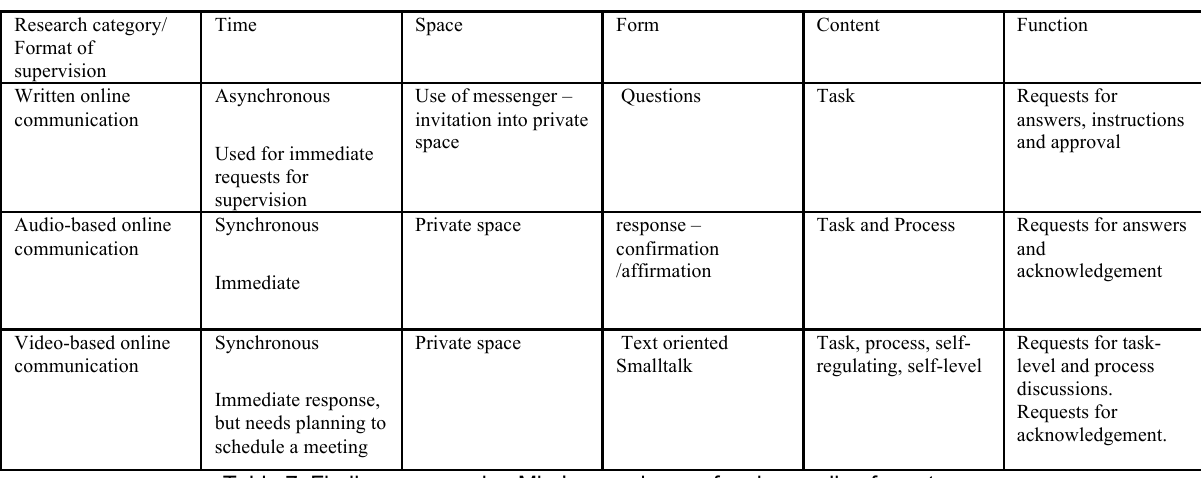
Table 7: Findings concerning Mira’s experience of various online